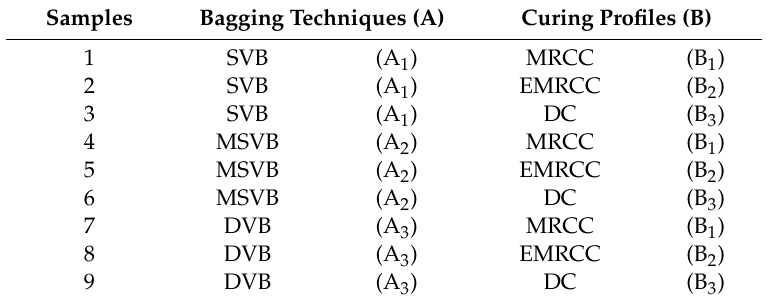
Table 1. Experimental plan for both concave- and convex-cornered composite laminates using Taguchi L 9 orthogonal array.